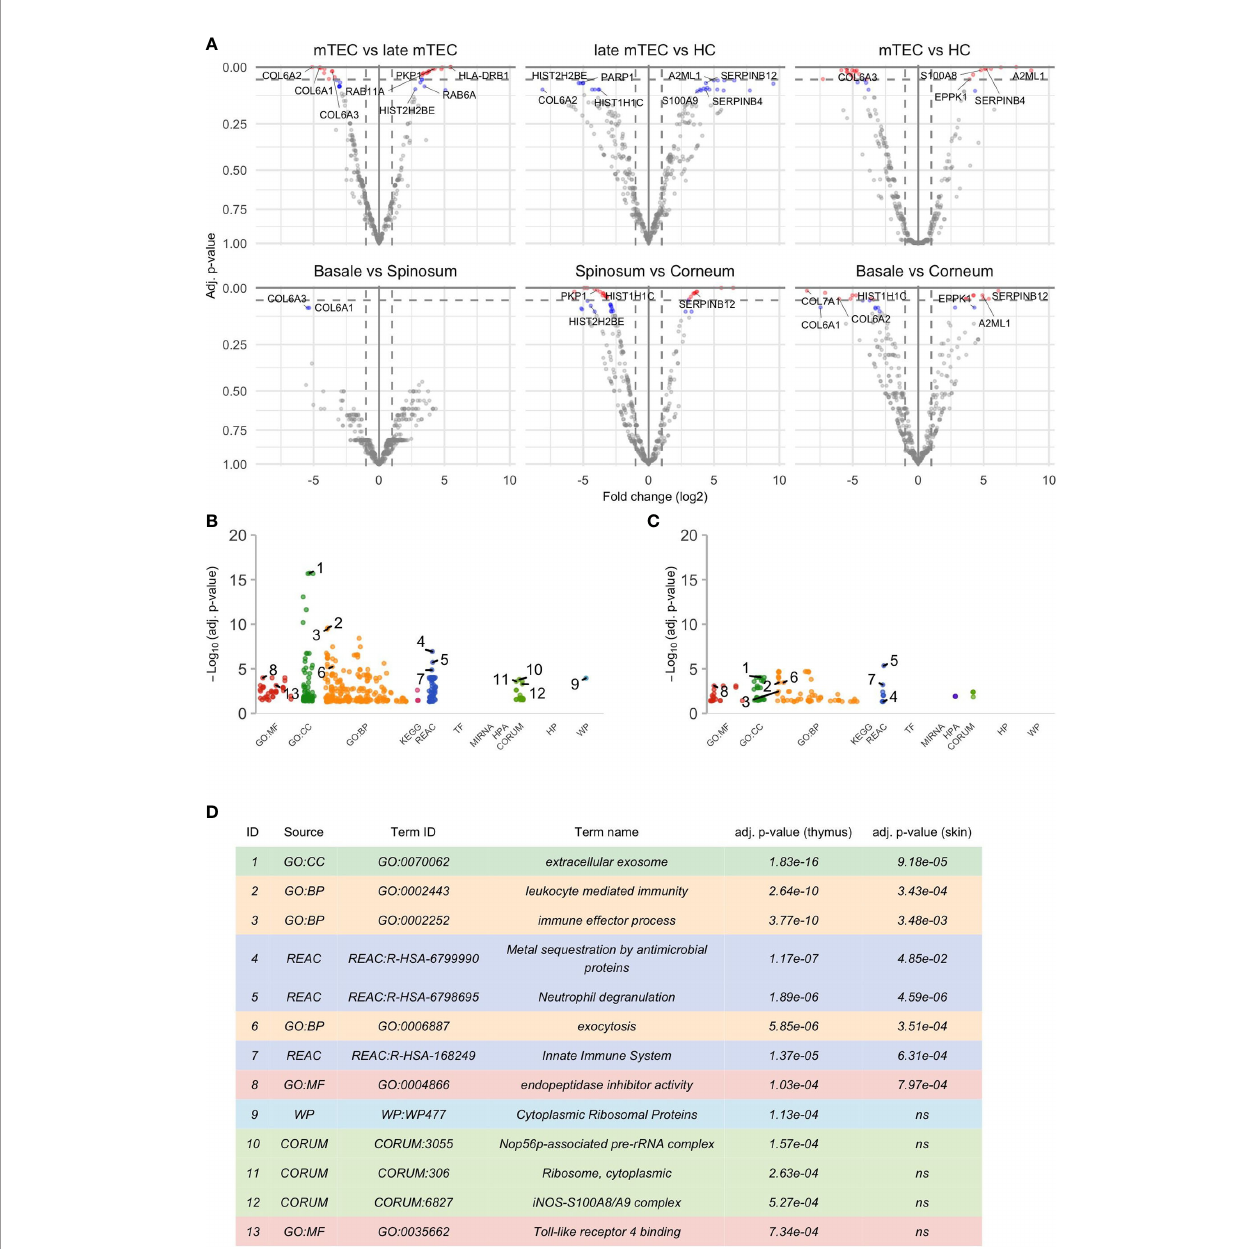
FIGURE 1 | Results of the differential analysis. (A) Volcano plots of differential analysis. The x- and y-axis of the volcano plot show log 2 of fold change (FC) and negative log 10 of p-values respectively. There are altogether 6 volcano plots for each groupwise comparison shown in the title of the plot. The fi rst source material name in the title always corresponds to the reference group and thus positive log 2 FC indicates an increase in the later differentiation stage compared to the earlier. Proteins with adj. p-value ≤ 0.05 are colored red, proteins with adj. p-value >0.5 and ≤ 0.1 are colored blue and a selection of them are named by their underlying genes. Only some top genes are shown by names, for full list of genes please see Table S1 , S2 . The results offunctional enrichment analysis of genes with adj. p-value ≤ 0.1 are visualized by Manhattan plots (B, C) that correspond to signi fi cant gene sets in the thymus and epidermis respectively. More speci fi cally, these plots convey information about Gene Ontology (GO) with “ MF ” describing the molecular functions of the gene products, “ BP ” the biological processes in which they are involved in and “ CC ” the cellular component where the gene products are located. In addition, there are molecular pathways in which gene sets are enriched in (KEGG, REAC, WP), putative transcription factor binding sites (TF), information about targeted miRNAs (MIRNA), protein complexes (CORUM, HPA) and associated human diseases (HP). For further information please see g:Pro fi ler (https://biit.cs.ut.ee/gpro fi ler). (D) shows further information about the selected GO terms in (B, C) . Some highly signi fi cant functional terms are not included in (D) due to virtual overlap with a functional pathway with even more signi fi cant